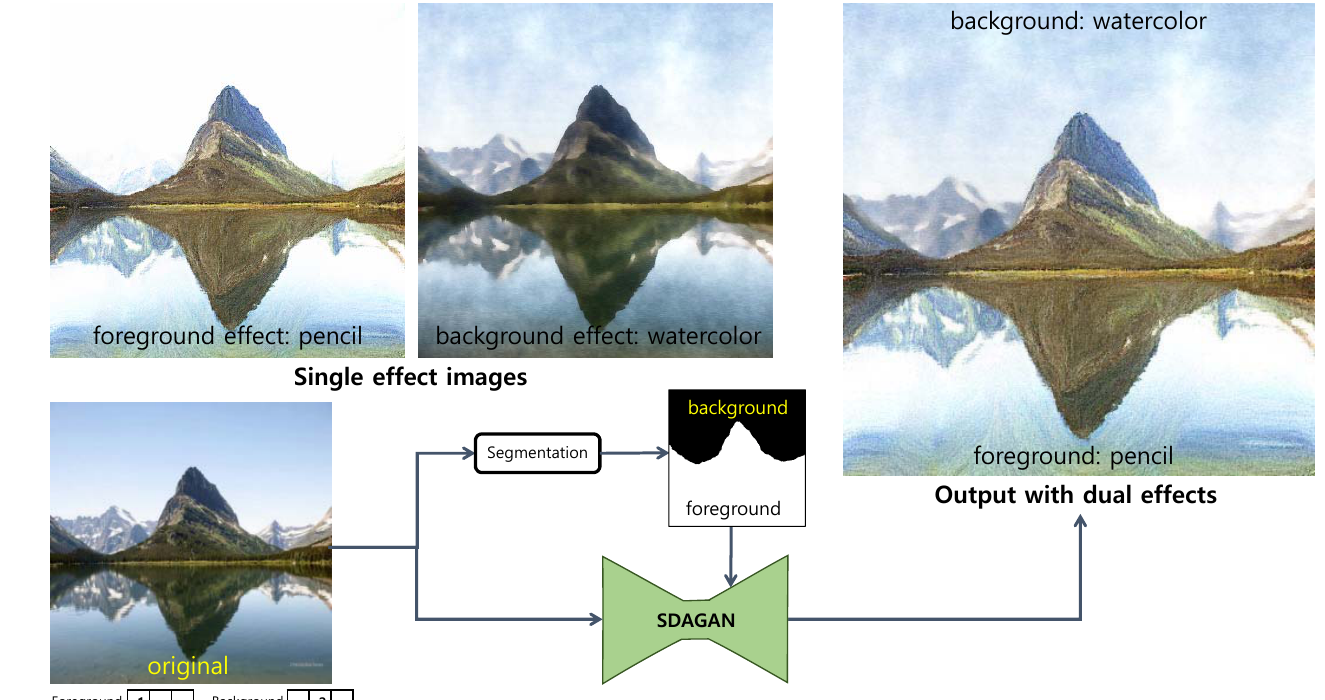
Figure 13. Dual artistic media effects with pencil drawing and watercolor using SDAGAN